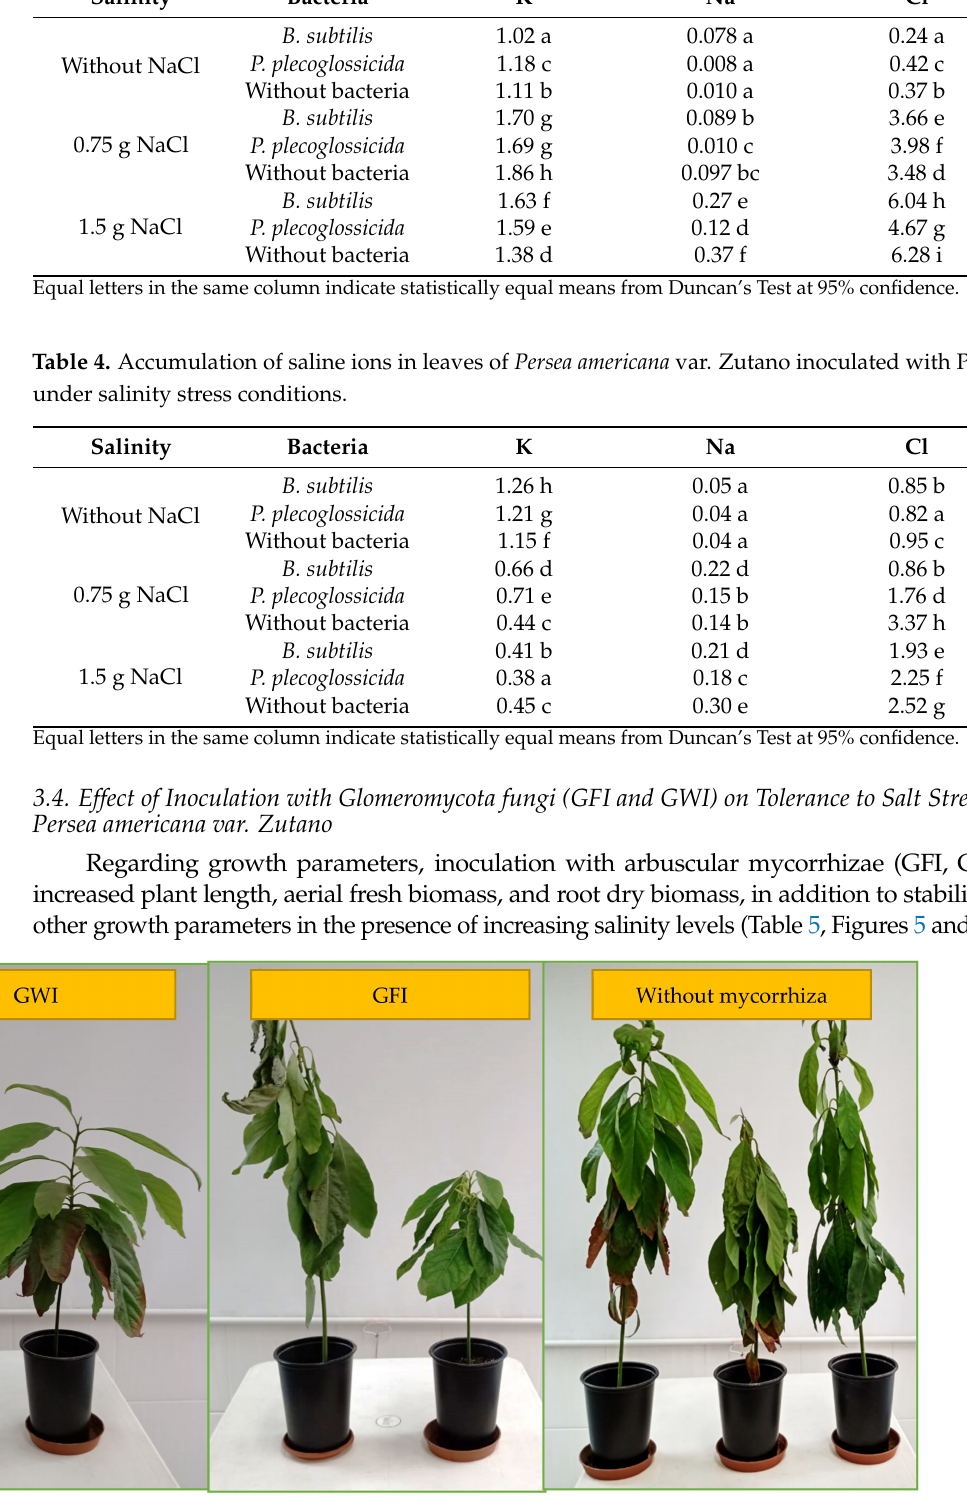
Figure 5. Effect of inoculation with arbuscular mycorrhizae on Persea americana var. Zutano under salinity stress